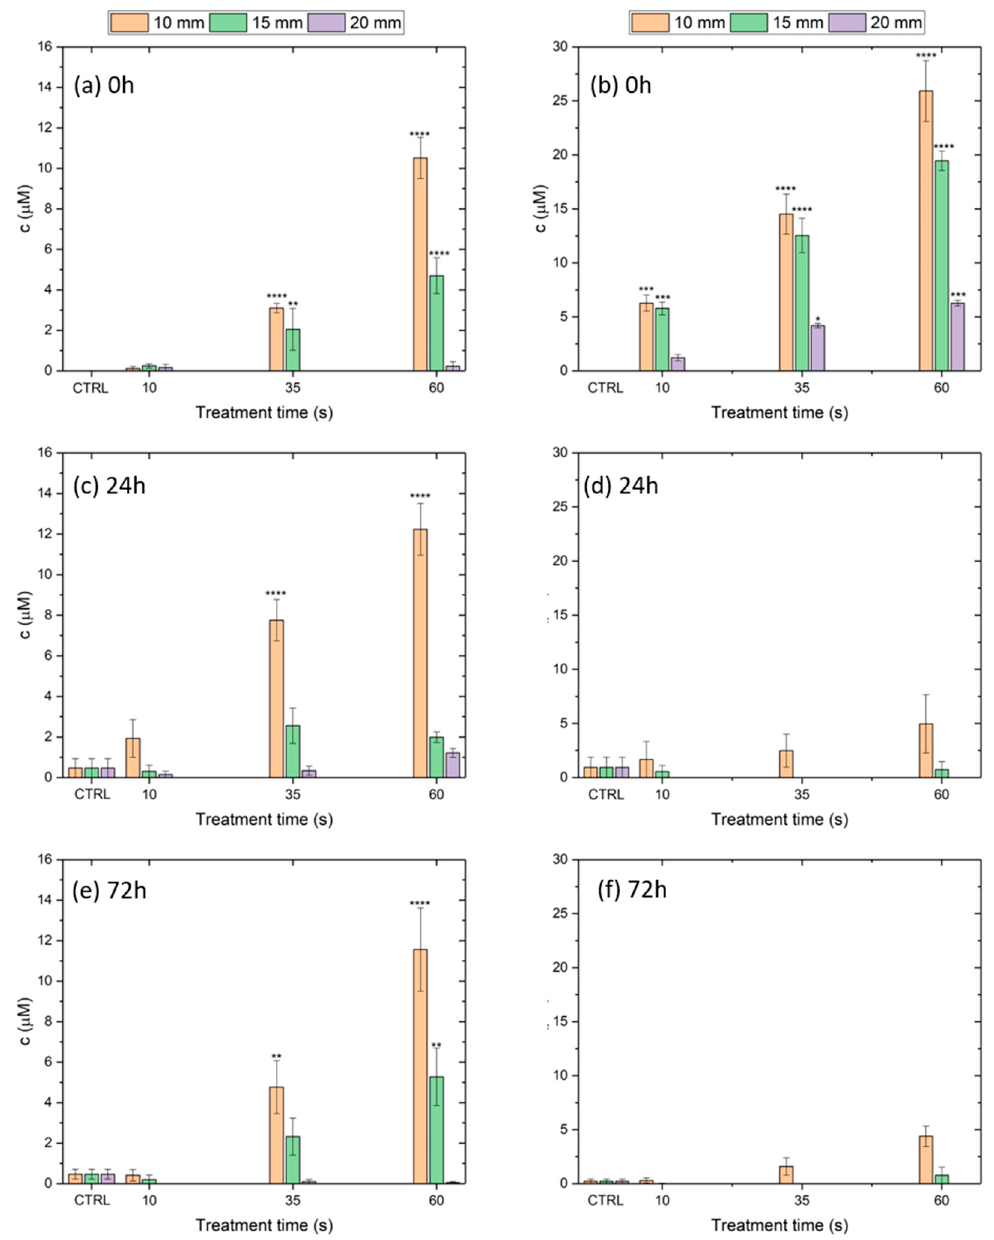
Figure 5. Concentration of NO 2 − ( left ) and H 2 O 2 ( right ) in PAM measured ( a , b ) 0 h, ( c , d ) 24 h and ( e , f ) 72 h after plasma treatment. Results are presented as mean values ± SEM. * p < 0.03; ** p < 0.002; *** p < 0.0002; **** p < 0.0001 (two-way ANOVA, Dunnet’s post-tests; n > 3).